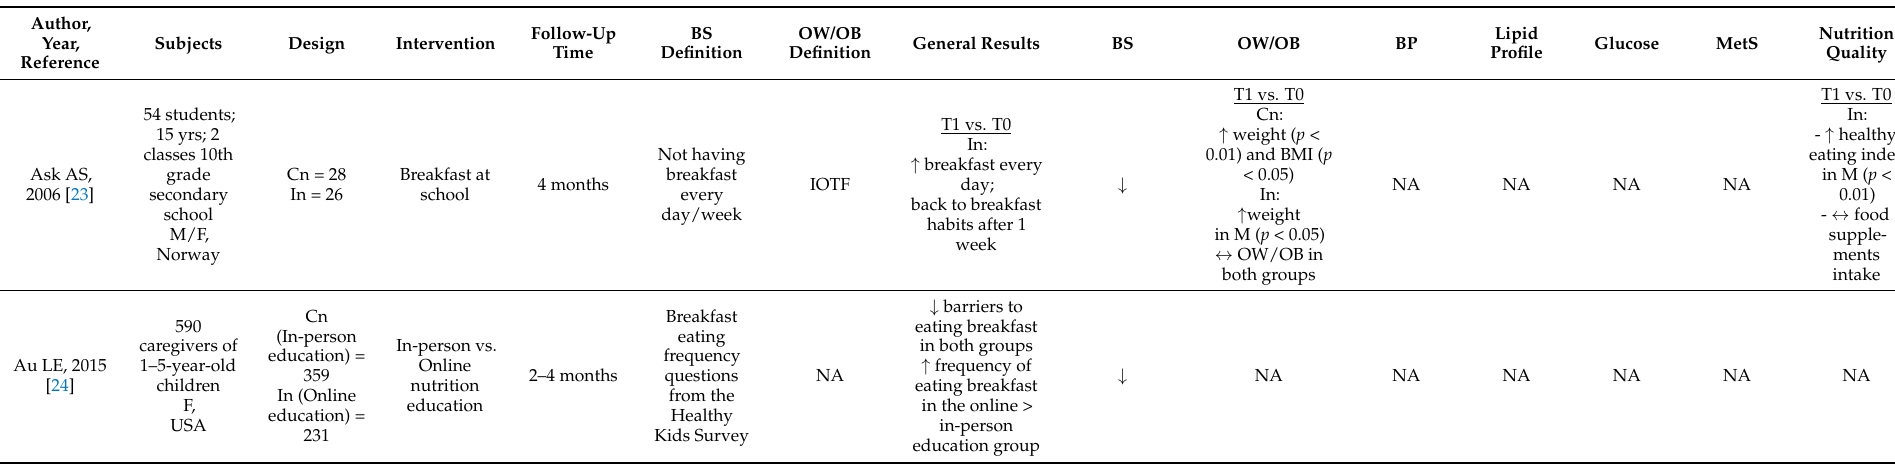
Table 2. Characteristics and results of RCTs included in the systematic